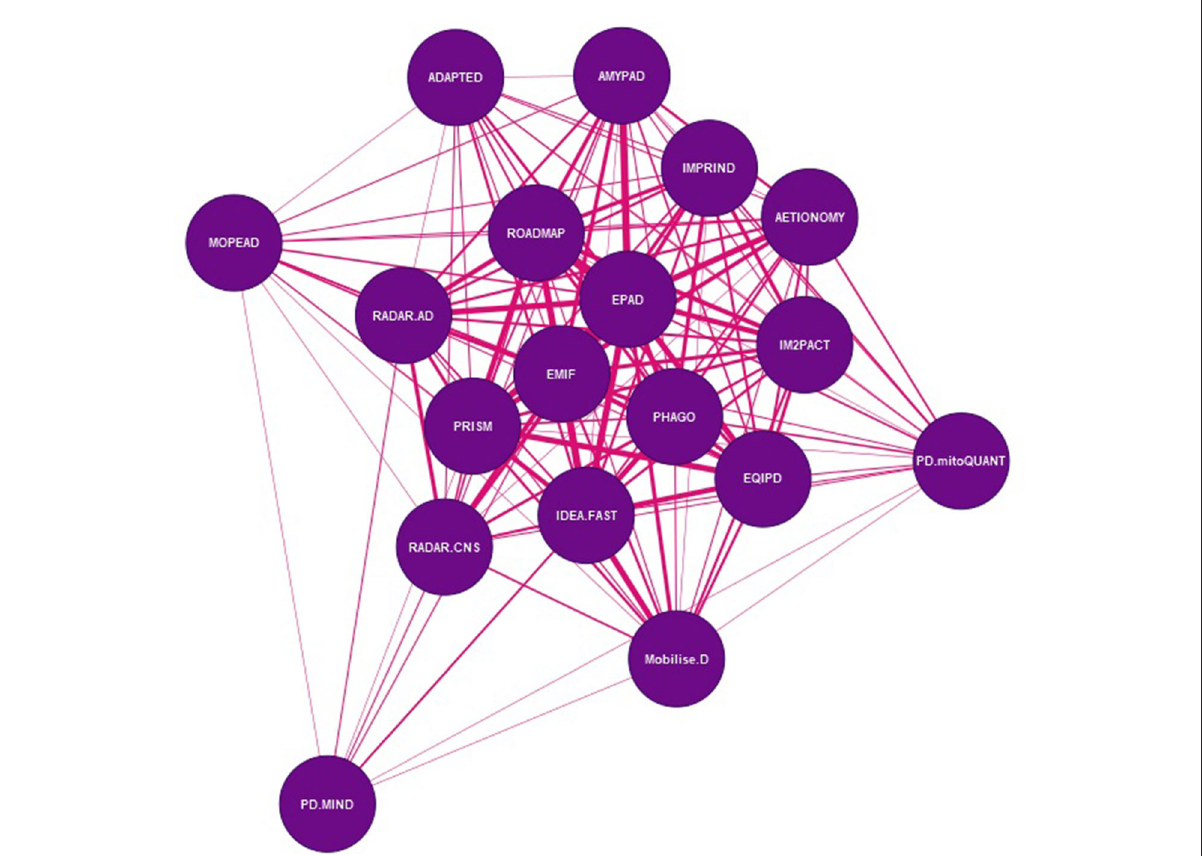
FIGURE3 Network of shared organisations in IMI NDD projects. Each node in the network represents an IMI project. The lines between the nodes are weighted to show the number of organisations that participate in both projects – the wider the connector, the higher the number of shared organisations between